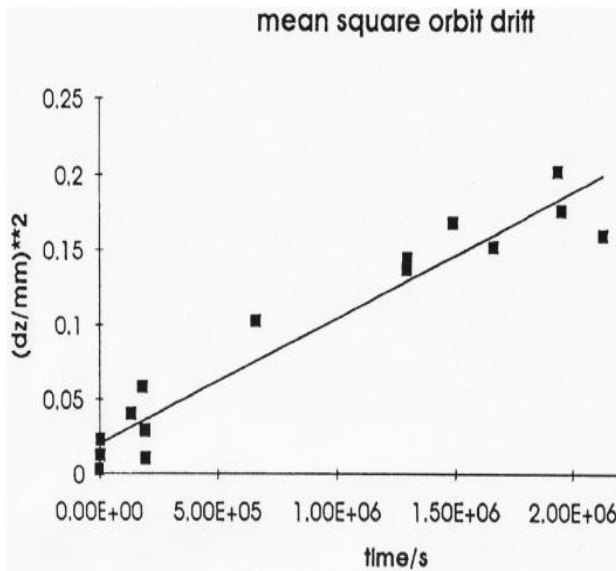
FIG. 2. PSD of the HERA-proton orbit vertical motion nor- malized to a specific location of the ring. The dashed line corresponds to the ATL law